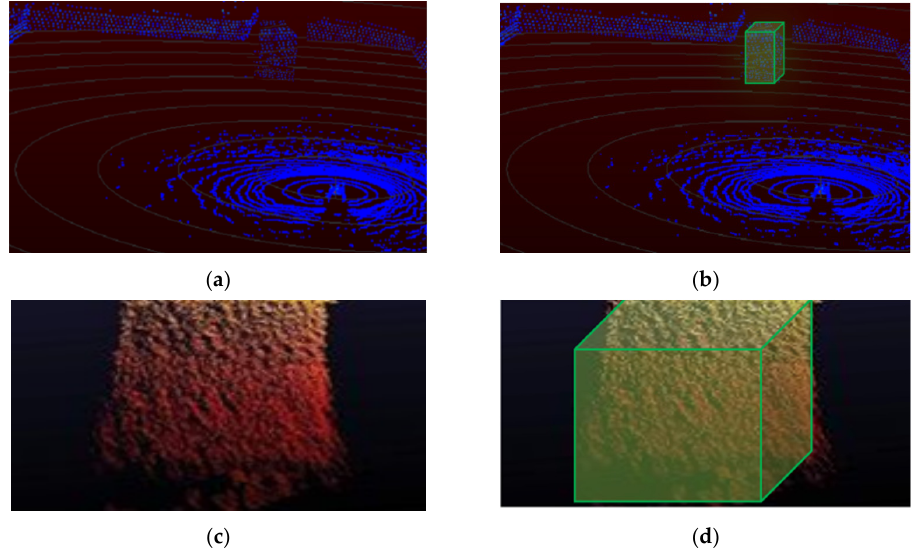
Figure 24. Fusion detection results of the iceberg model obstacle. ( a ) Overwater point cloud image of the obstacle. ( b ) Overwater 3D regression border of the obstacle. ( c ) Underwater point cloud image of the obstacle. ( d ) Underwater 3D regression border of the obstacle.